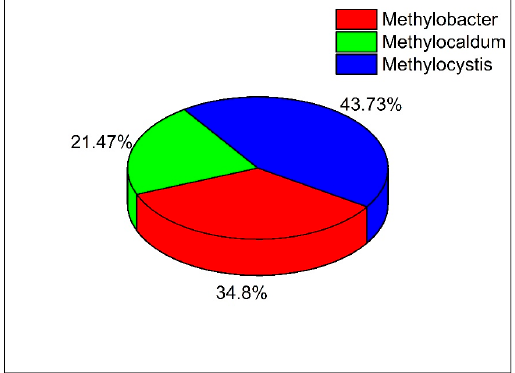
Figure 1. Types and proportions of methane-oxidizing bacteria in aged refuse.